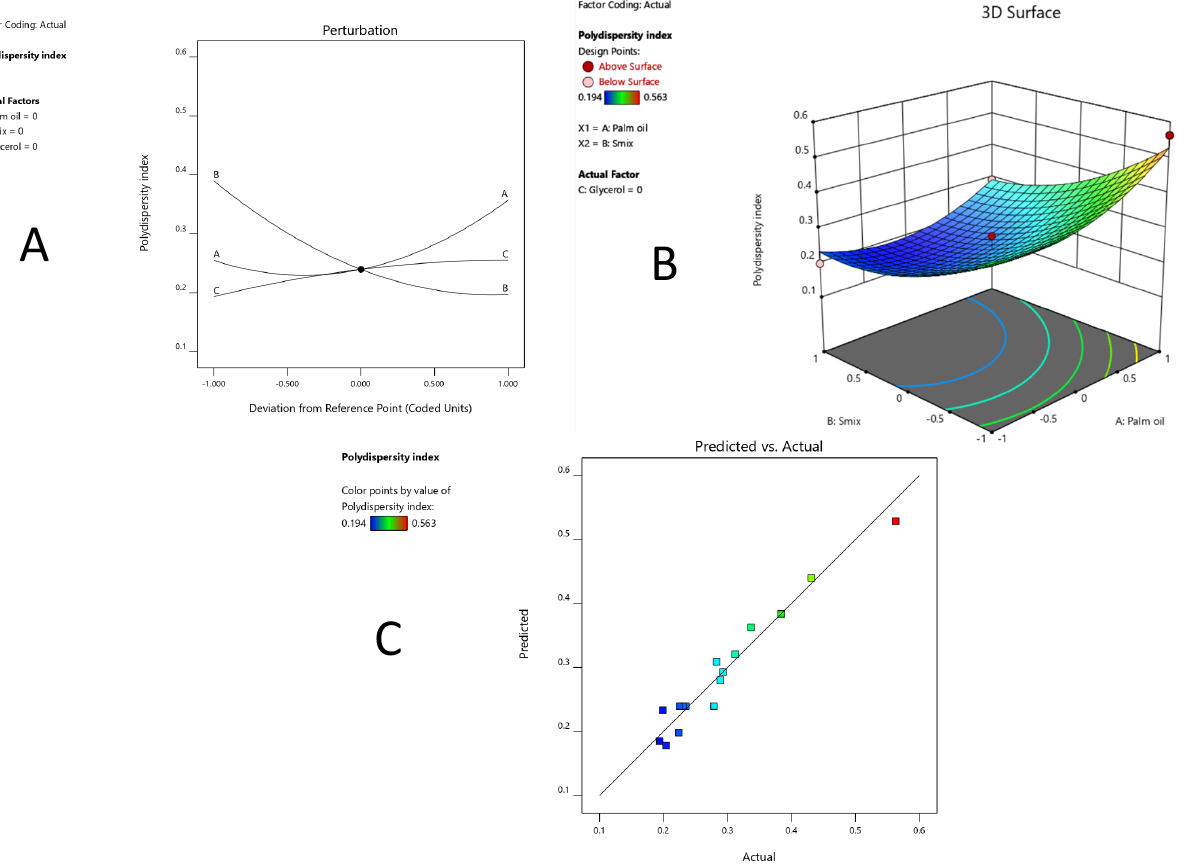
Figure 2. Effect of independent variables on PDI: ( A ) Perturbation graph of the droplet size, ( B ) 3D surface plot, ( C ) predicted vs. actual